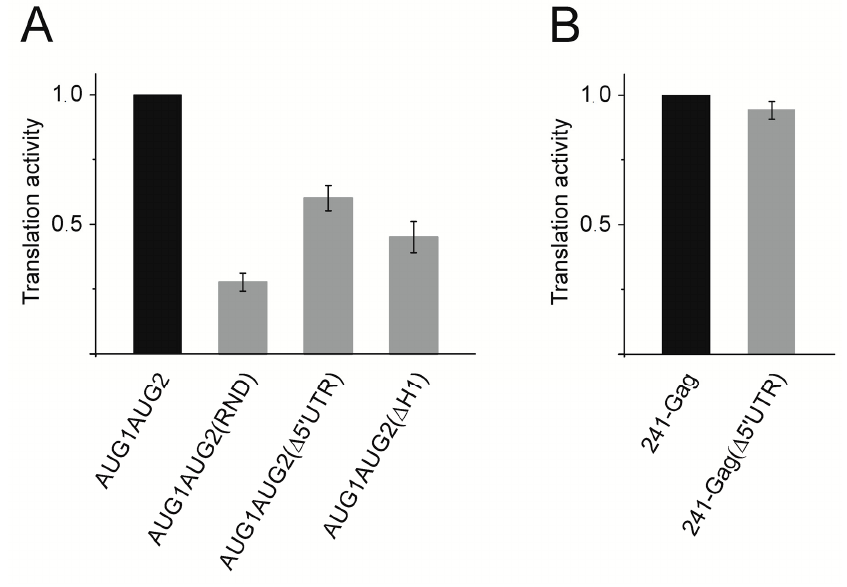
Figure 7. In vitro translation of the capped variants of the AUG1AUG2 RNA and 241-Gag RNA. Translational efficiency was normalized to the amount of the protein product synthesized from AUG1AUG2 RNA ( A ) or 241-Gag RNA ( B